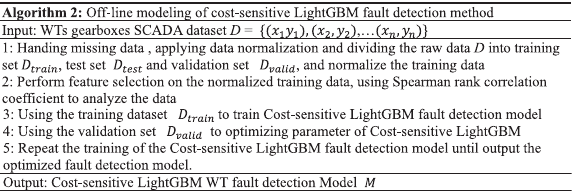
Figure 3 . The main steps of of fl ine modeling are given as follows.